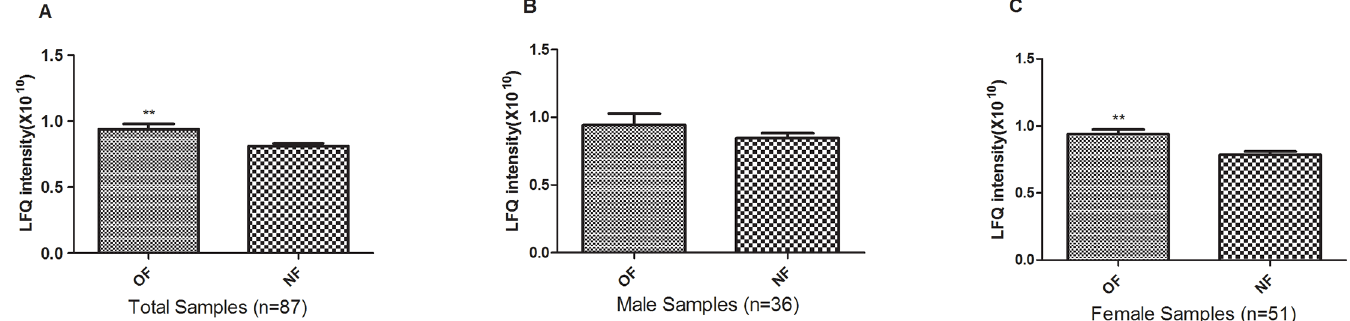
Fig 1. Up-regulation of PBM-expressed Anxa2 protein in OF versus NF subjects. Presented are Anxa2 protein abundances (Label-Free Quantification [LFQ] intensity) in PBM in Sample 1. The data is described as mean±SD. (cid:3)(cid:3) : P < 0.01, as compared with NF subjects.